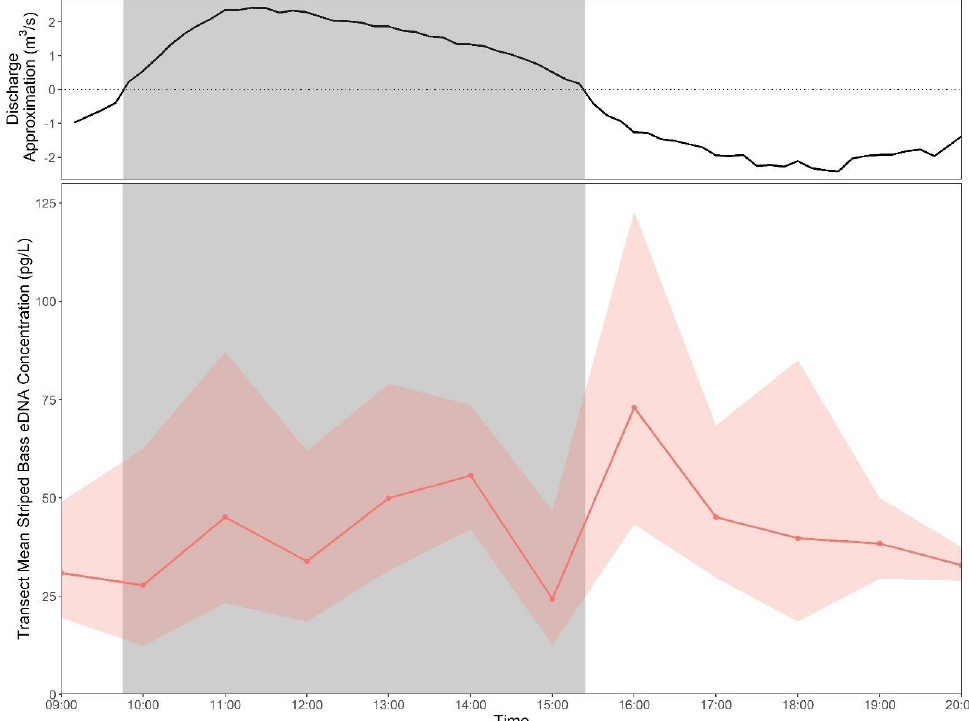
Figure 5. Back-transformed time point mean striped bass eDNA concentrations (pg/L) ± standard deviation for tidal time series samples collected from transect 6 in 2020. A discharge approximation (m 3 /s) was calculated as the sum of flow speed (m/s) at each depth interval (0.25 m) for a 1 m transect under the ADCP. Shaded area represents falling tide as determined by ADCP measurements.